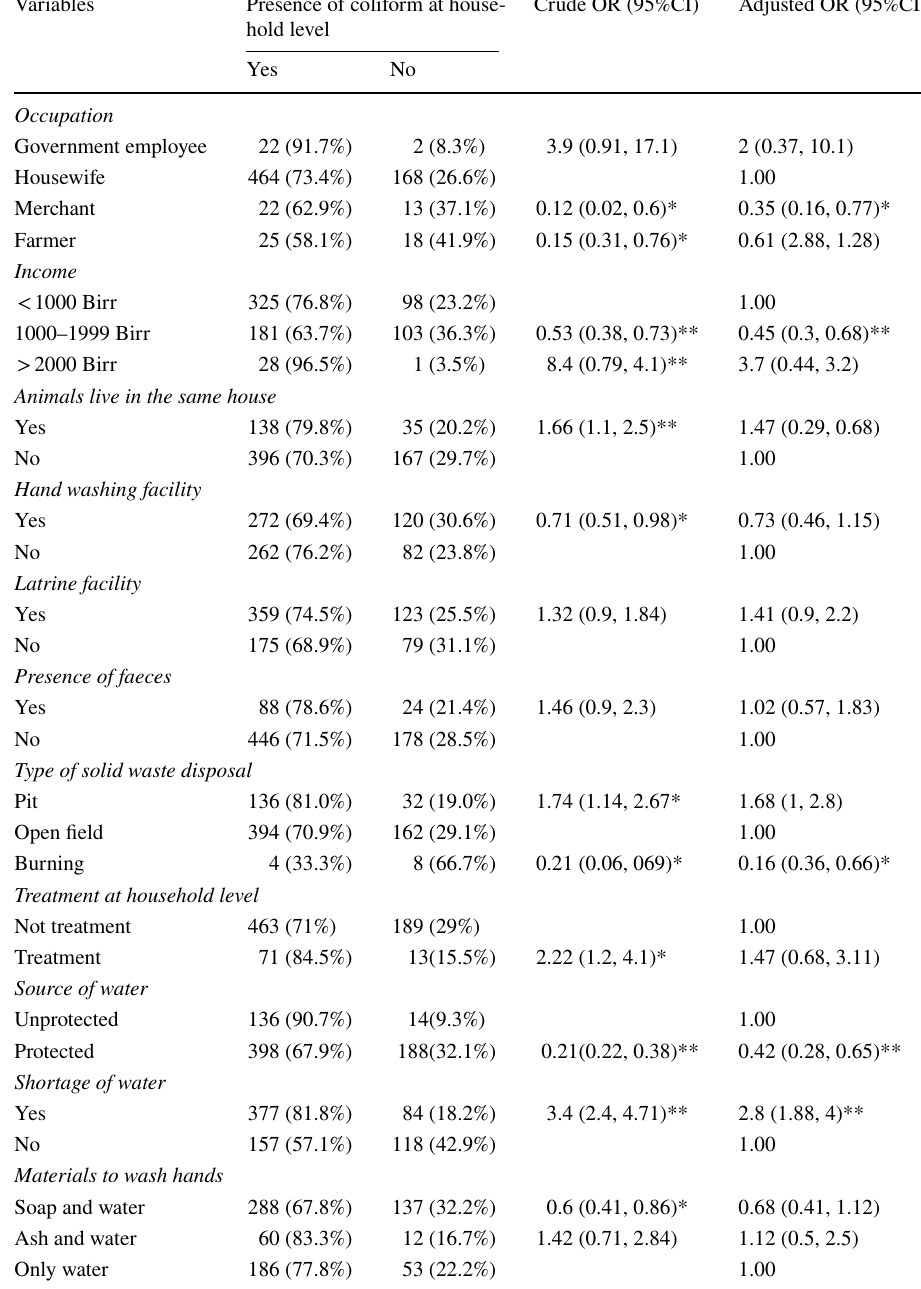
Crude OR (95%CI) Adjusted OR